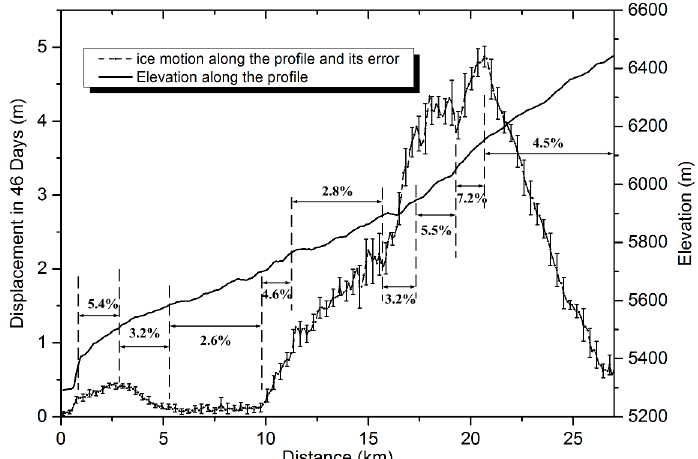
Figure 8. Ice motion and elevation profiles along the central line of the Chongce Glacier surface and percentages marked between two dotted lines are the slopes of the terrain in corresponding sections.